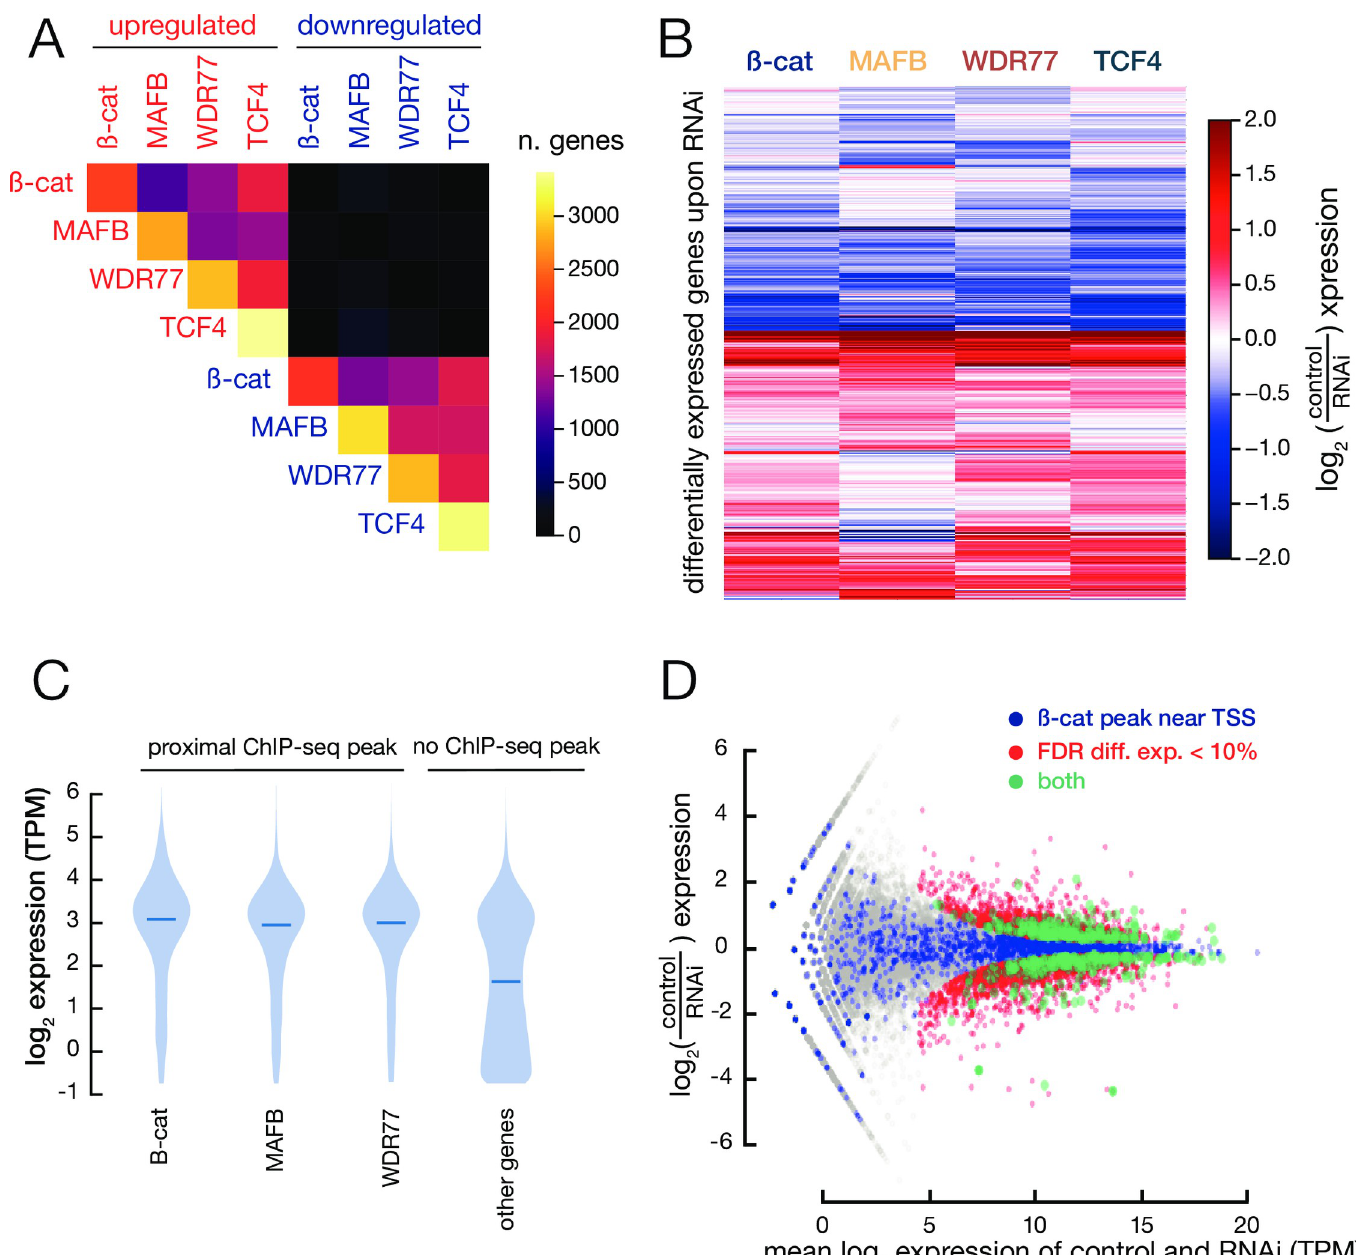
Fig 5. ß-catenin/MafB/WDR77 binding is correlated with transcriptional activity. (A) Number of genes shared between upregulated (top and left) and downregulated (bottom and right) gene sets following RNAi against the indicated proteins. The top-right black square (near-zero shared genes) indicates that the directionality of expression change is highly conserved. (B) Log 2 expression fold-change of individual protein-coding genes (rows of the heatmap) between control and RNAi knockdown. (C) Violin plot showing expression levels in transformed cells of sets of genes defined as with or without proximal ß-catenin/MafB/WDR77 ChIP-seq peaks. (D) MA plot showing the gene expression levels of ß-catenin RNAi and control. Blue dots indicate genes whose TSSs are bound by ß-catenin, red dots indicate differentially expressed genes (FDR < 10%), and green dots indicate differentially expressed genes that are bound by ß-catenin (both). The few purple dots indicate that ß-catenin binding is not causally associated with significant changes in gene expression after RNAi